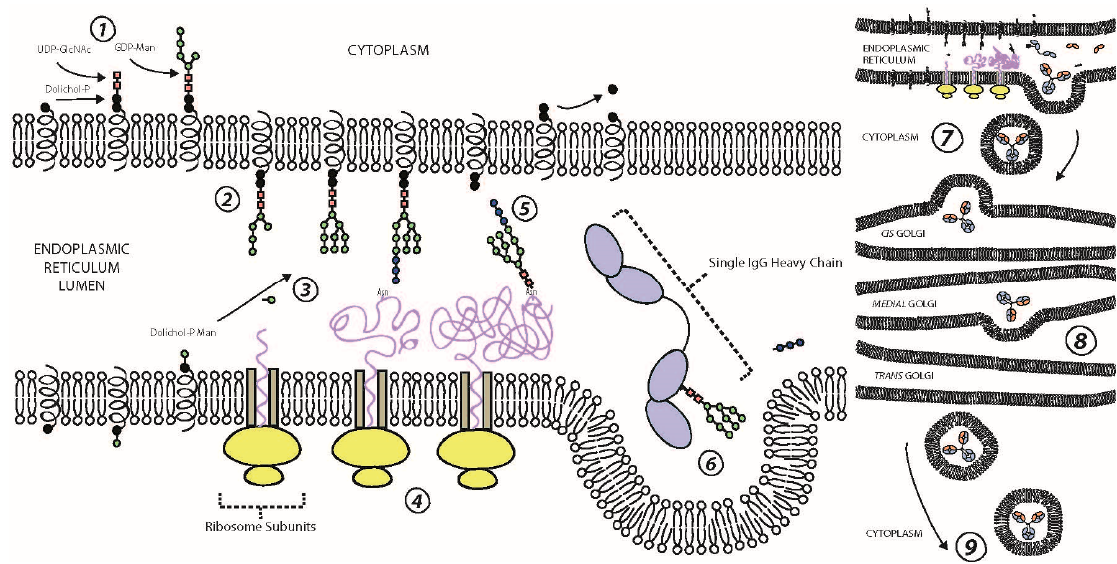
Figure 2. Biosynthesis of the IgG glycoprotein. ① N- glycan biosynthesis begins on the endoplasmic reticulum membrane where two N- acetylglucosamines (UDP-GlcNAc) and five mannose (GDP-Man) sugar nucleotides contribute the given monosacchairdes to a dolichol-phosphate (Dolichol-P) donor molecule on the cytoplasmic side. ② The whole Dolichol-P attached N- glycan is flipped so it is on the luminal side of the endoplasmic reticulum. ③ Dolichol-P flips individual sugar nucleotides from the cytoplasm to the lumen. ④ In tandem, the ribosomes biosynthesise the polypeptide structure of the IgG. ⑤ Oligosaccharyltransferase transfers the N -glycan moiety from Dolichol-P to asparagine (Asn) 297 on the growing polypeptide. ⑥ The three terminal N- acetylglucosamine sugar nucleotides are removed over two steps, following folding and assembly of the nascent IgG, and this signals the transfer of the IgG from the endoplasmic reticulum to the Golgi apparatus. ⑦ , ⑧ The IgG components move through the Golgi apparatus, where different glycosyltransferases and glycosylhydrolases add and remove respectively, different sugar nucleotides to the glycan moiety. ⑨ Following excretion from the trans Golgi, the final IgG glycoprotein either secreted from the B-cell lymphocyte or attached to the plasma membrane of the B-cell to become a B-cell receptor (BCR).